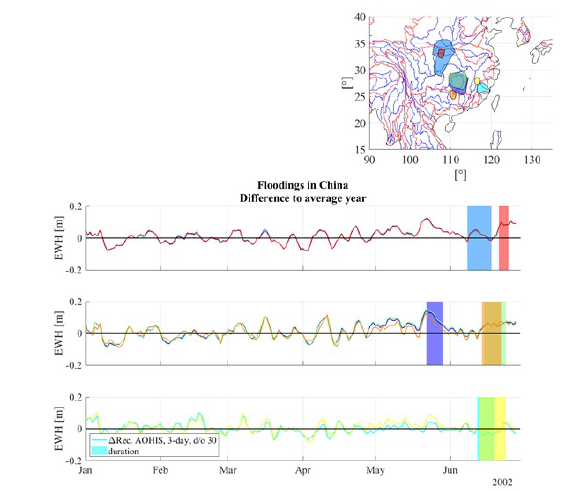
Fig. 9. Floods in China between January and June 2002 in a spatial plot (top, right) and the respective reconstructed HIS flood time series incl. ESA ESM HIS reference signal and the durations in the same